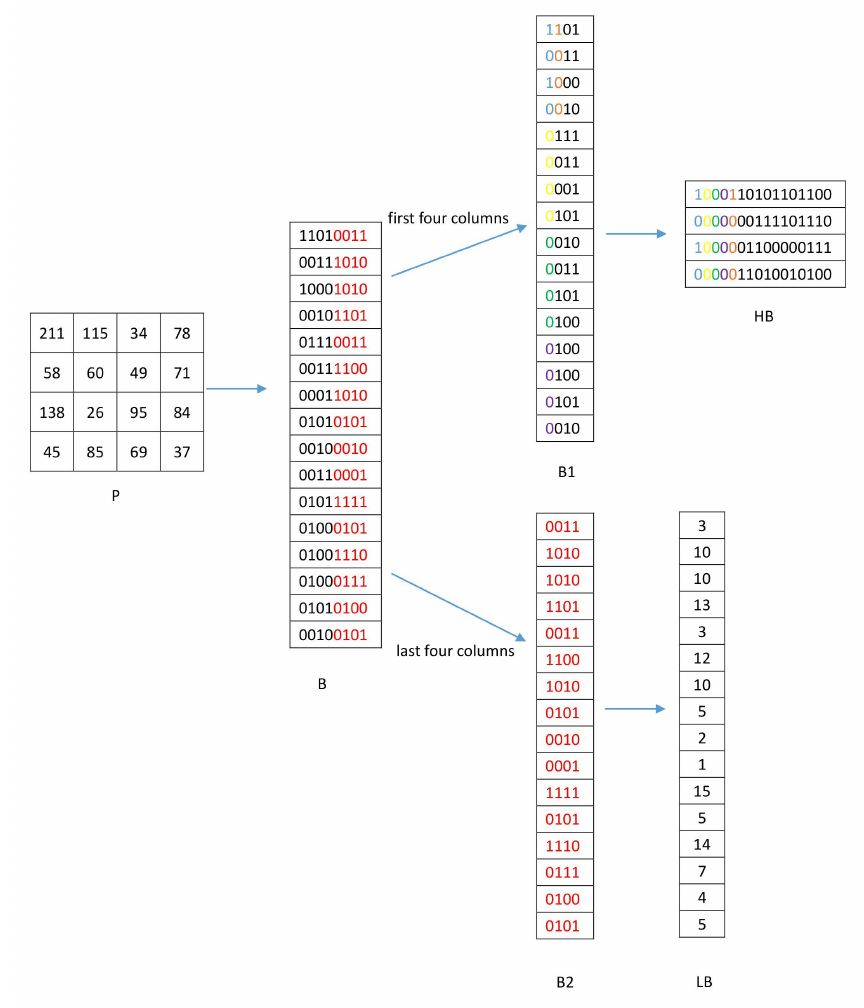
Figure 7. Example of operations in Steps